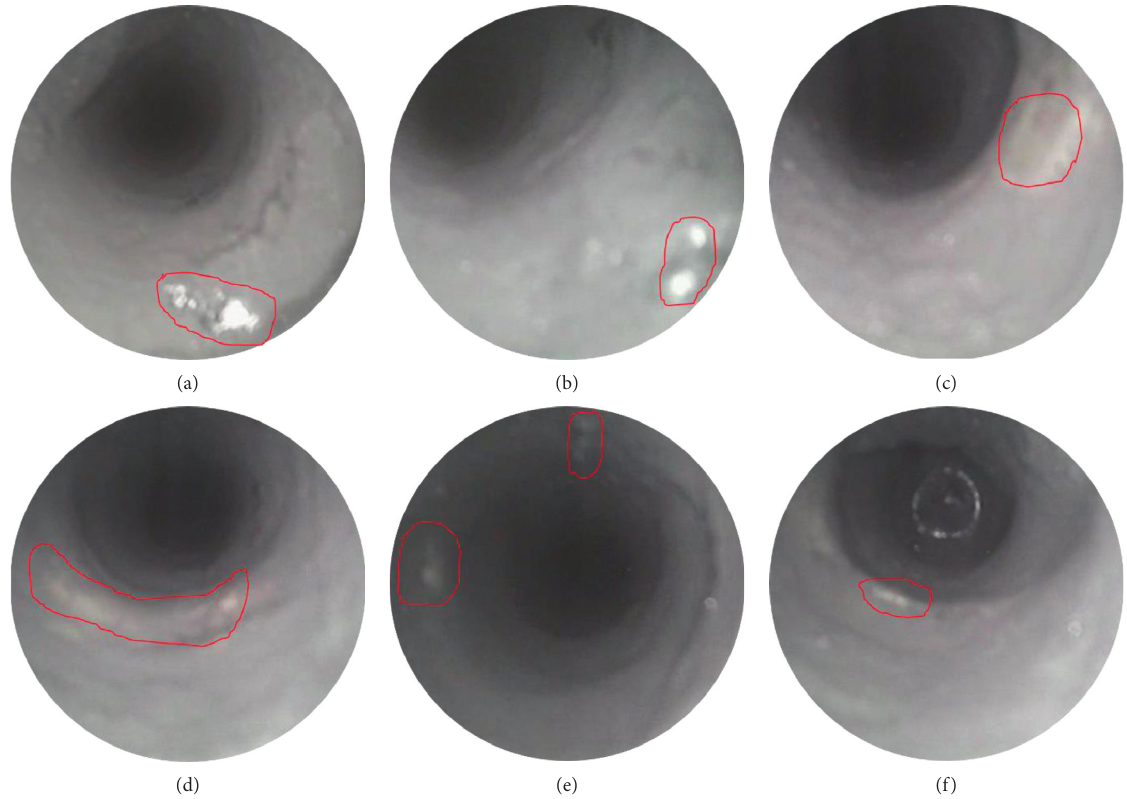
Figure 12: Drilling peeping characteristics of different hole depths. (a) 0.1m. (b) 0.5m. (c) 1.0m. (d) 1.5m. (e) 3.0m. (f)